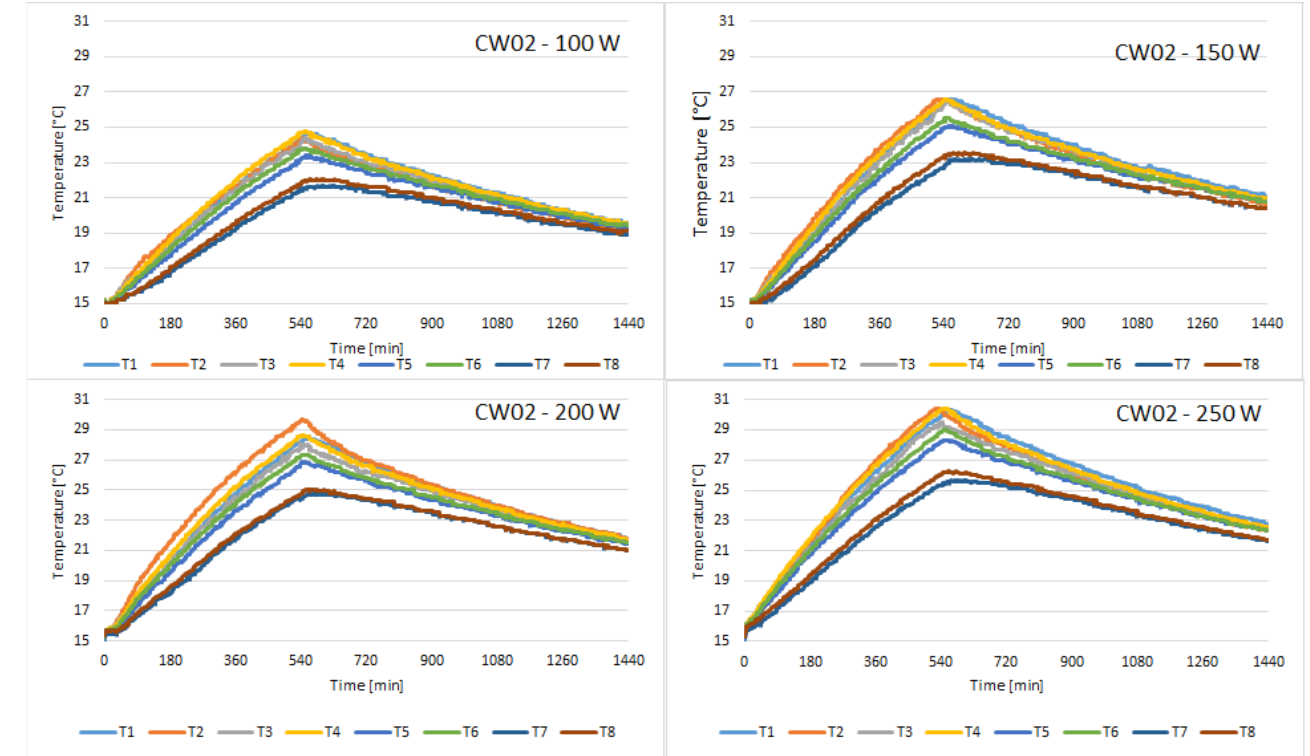
Figure 5. Temperature variation recorded by the sensors for concrete sample CW02.